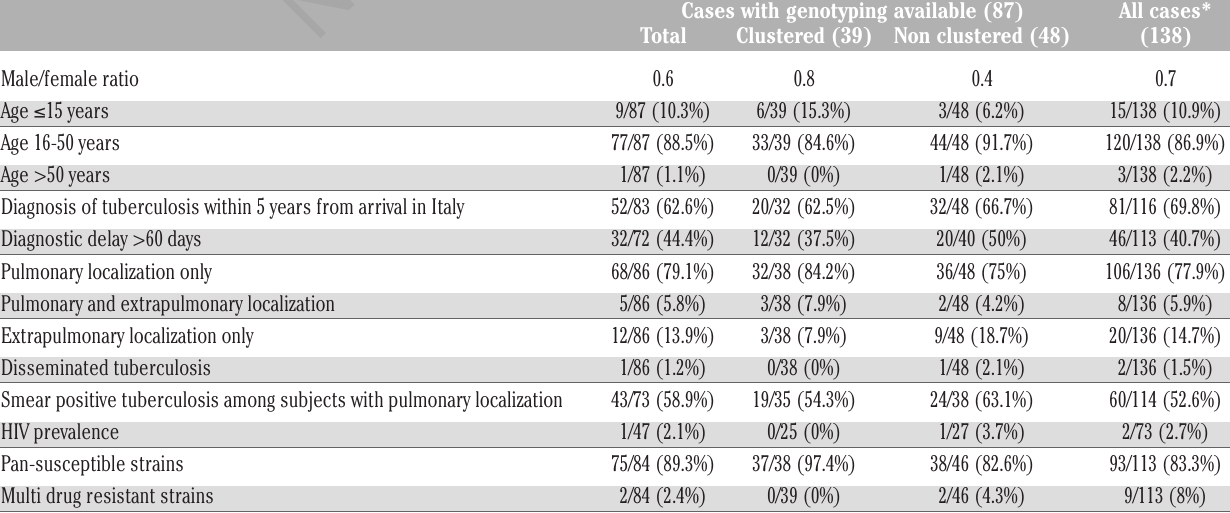
Table 1. Clinical, microbiological and epidemiological features of tuberculosis cases notified in Peruvian citizens resident in the Health District of Florence, Italy, in the period 2001-2010. Cases with genotyping available (87)